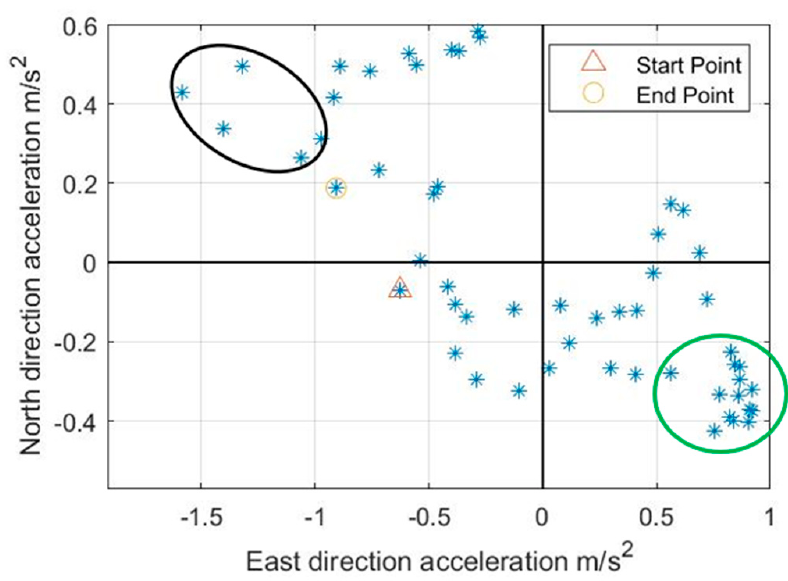
Figure 10. In − step east vs. north accelerations scatter.